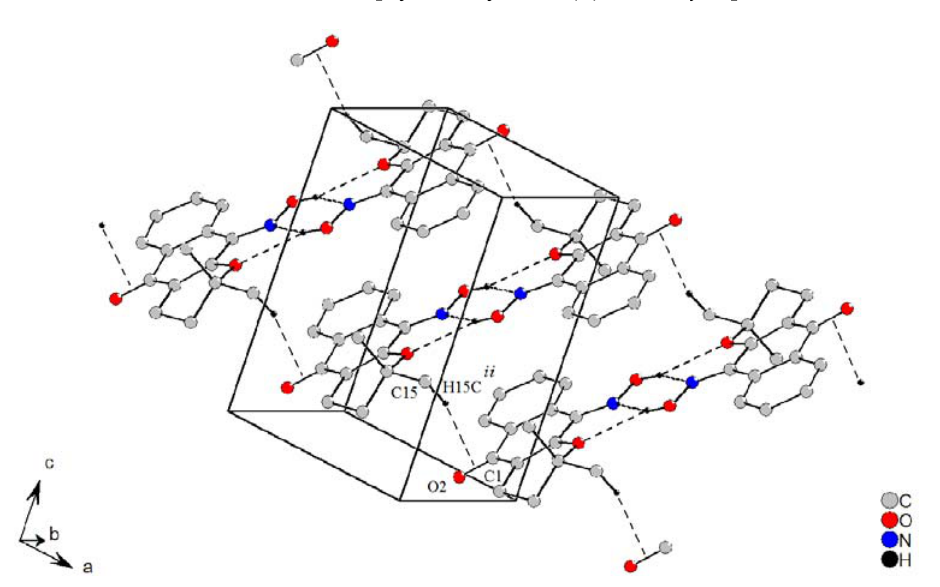
Figure 4. Self assembly by tectons linked through C-H … π noncovalent interactions. The intramolecular interaction is omitted. [Symmetry code ( ii ) = 1 +x, y, z